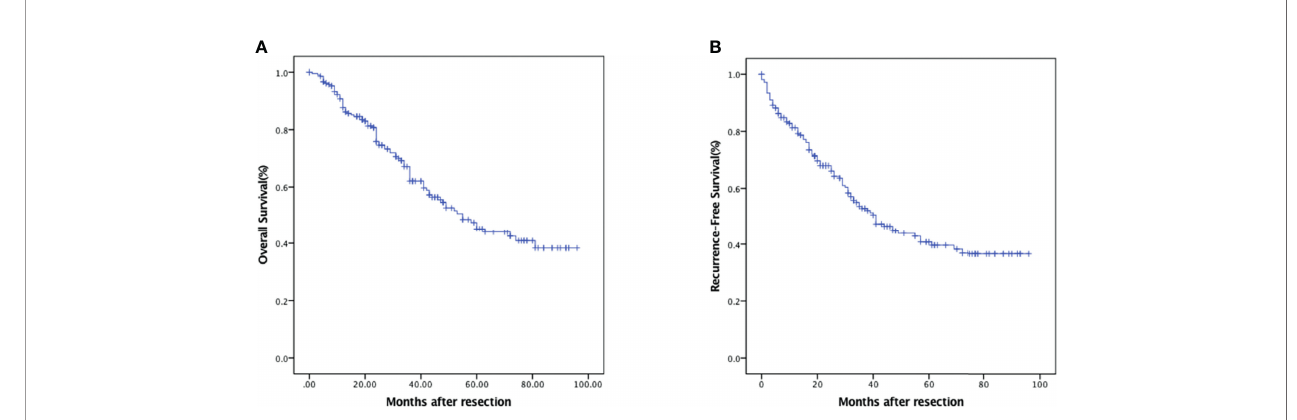
TABLE 3 | Univariate and multivariate analyses of prognostic factors for overall survival of patients. Variable Univariate Multivariate